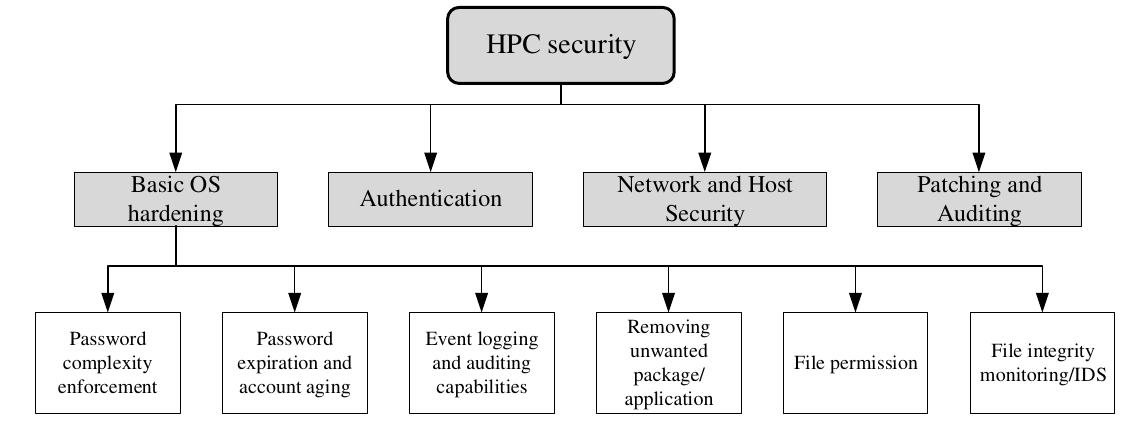
Figure 2. Strategies to secure HPC systems